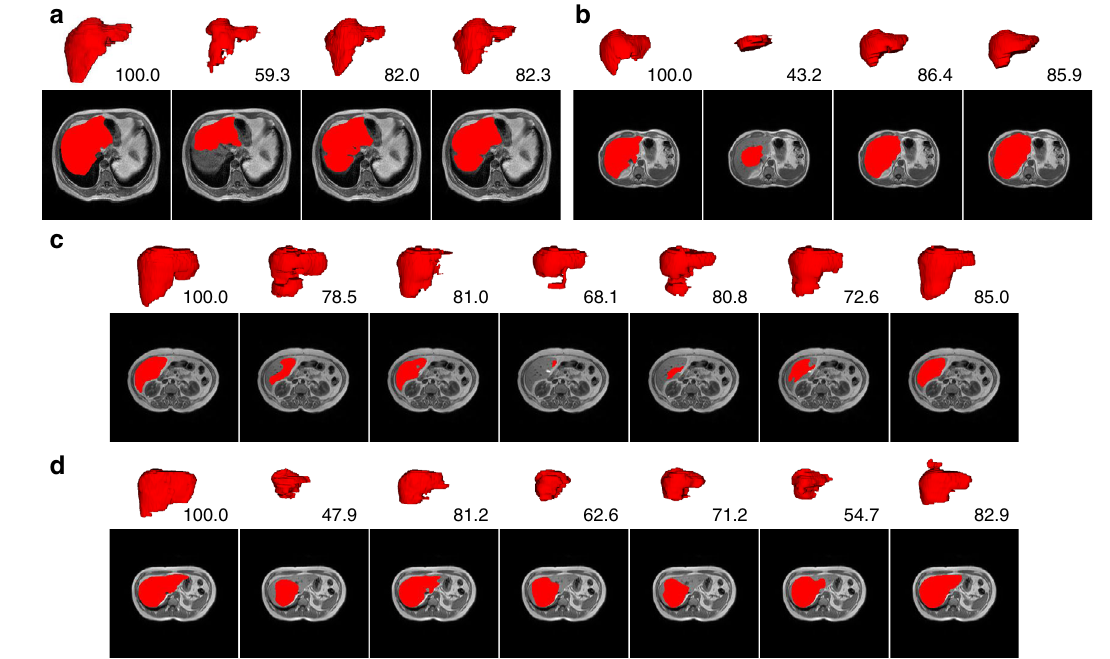
Fig. 2 Visualizations of label correction and segmentation results for SSL. a , b Example results of training data label correction. The red regions in the four images from left to right correspond to the high-quality label, the low-quality label utilized to train the model, and the self-corrected labels of the two networks, respectively. c , d Example segmentation results. The fi rst columns are the corresponding high-quality labels. The second to the last columns are the results achieved under settings S02, S04, S06, S08, S10, and S12 in Table 1. The numbers are the DSC values (%). In each sub fi gure, the fi rst row (white background) shows the segmentation results in 3D rendering, and the second row (black background) gives the results of a single selected slice in 2D.